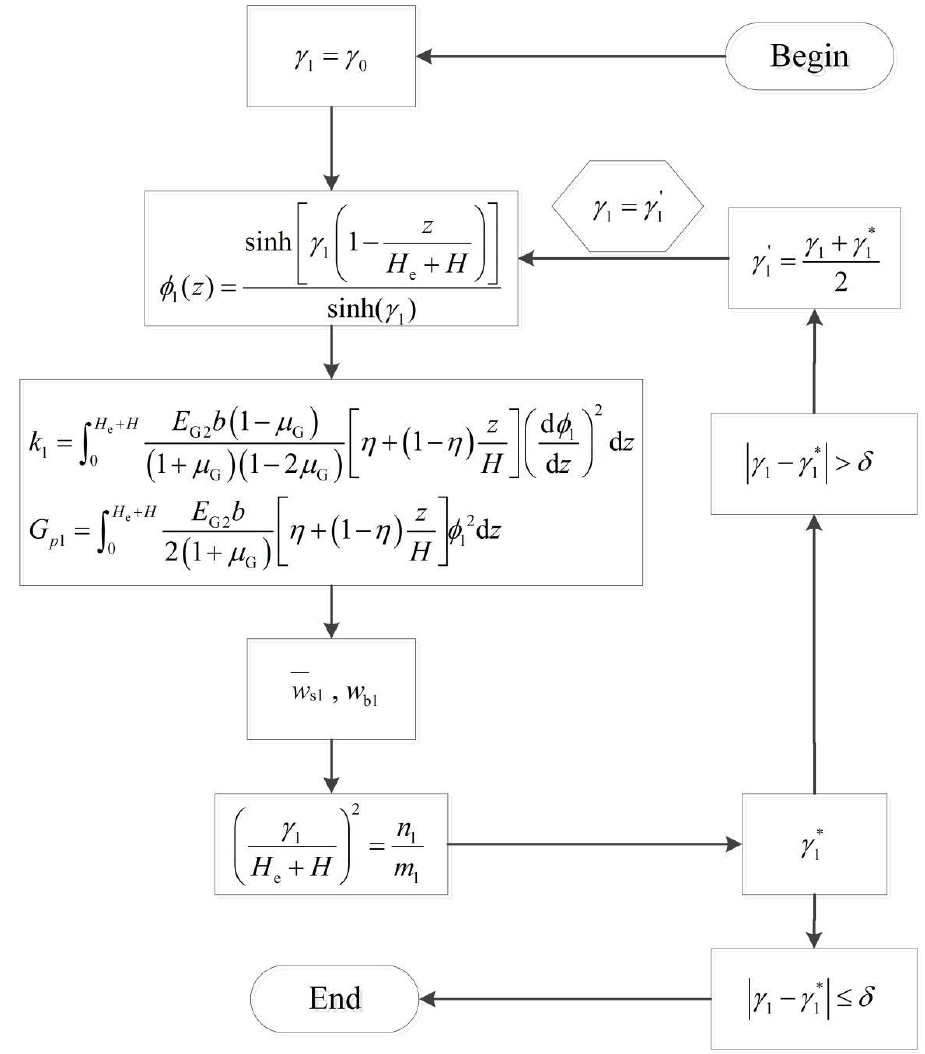
Figure 3. Iterative flowchart of attenuation parameters for Gibson elastic foundations. More importantly, by substituting the vertical deflection w si of the foundation surface into Formula (8), the deflection w bi of the finite-length beam considering the embedment depth effect can be obtained. Finally, other quantities in physics are derived from , bending moment M , and shear force b i b i